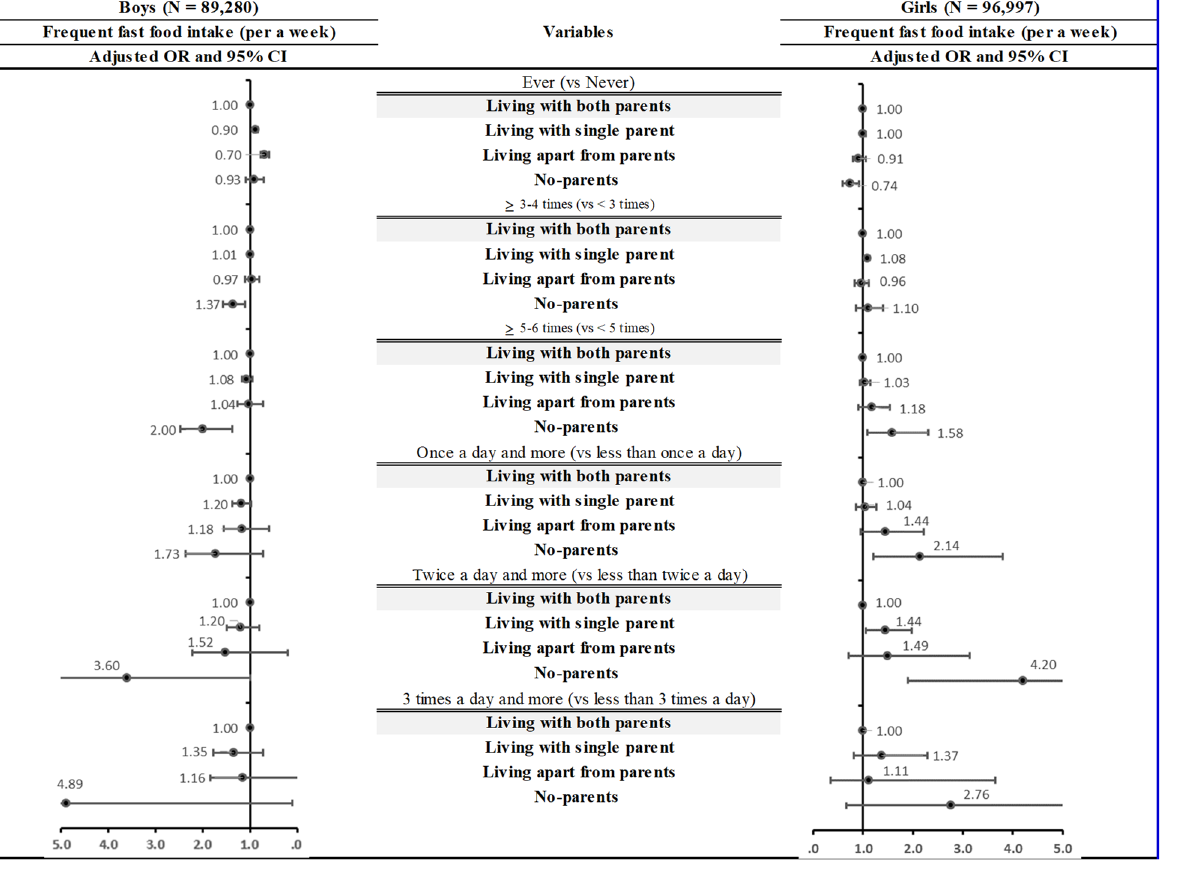
Figure 1. Results of sensitivity analysis by defining fast food intake. All covariates were adjusted. OR: Odds ratio; 95% CI: 95% Confidential Intervals.